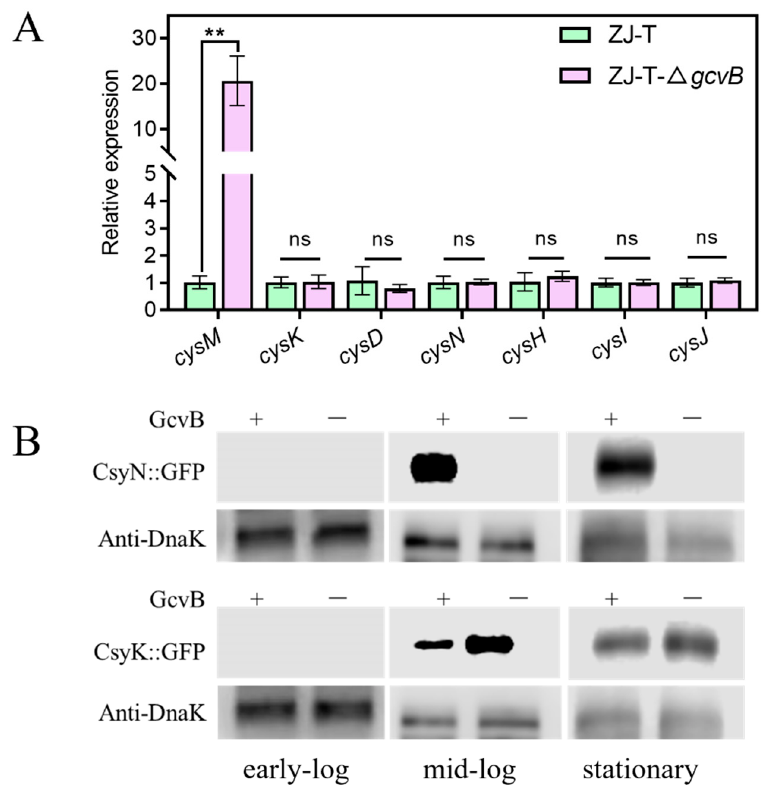
Figure 8. Effects of GcvB on sulfur and cysteine biosynthesis metabolism pathway. ( A ) Relative expression of genes involved in the sulfur and cysteine biosynthesis metabolism pathway by qRT-PCR (Student ’s t -test, p value: ns, >0.05, **, <0.01). The levels of gcvB were normalized to the internal control 16S rRNA level. Error bars indicate standard deviations; ( B ) Western blot detection of CysN and CysK translational fusion. For Western blotting, samples were harvested at OD600 of 0.3~0.4 (early-log), 1.0~1.5 (mid-log) and 3.0~4.0 (stationary) from LBS plus 5 µ g/mL Cm (chloramphenicol). Polyclonal anti-Dnak was used as loading control.